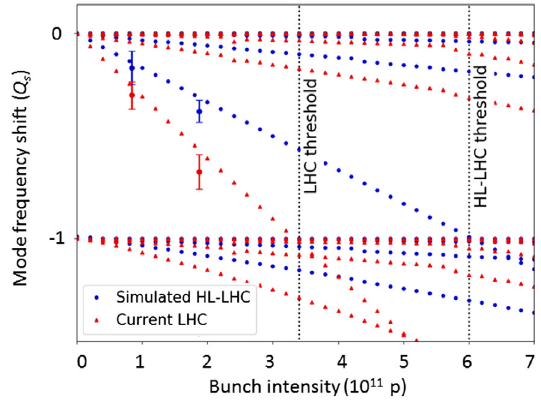
FIG. 10. The collimator upgrade is expected to increase the TMCI threshold at the top energy by nearly a factor of two in HL-LHC compared to LHC. Dots represent the simulated mode frequencies of the azimuthal modes 0 and − 1 and several most prominent radial modes: red for LCH and blue for HL-LHC for different bunch intensities. The measured mode frequency shifts (error bars) are in good agreement with the simulation predic- tions. Beam 1, E ¼ 6 . 5 TeV, Q 0 ¼ 5